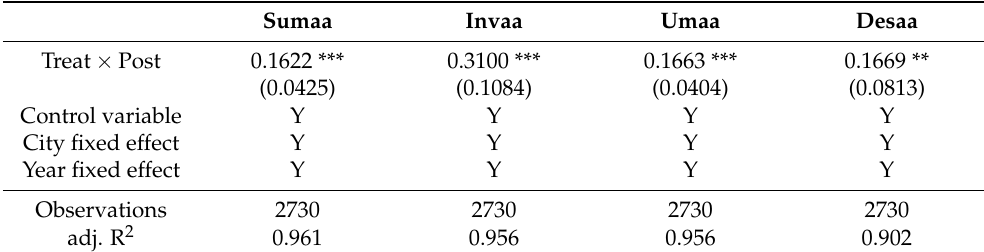
Table 8. Regression results of excluding samples from municipalities directly under the central